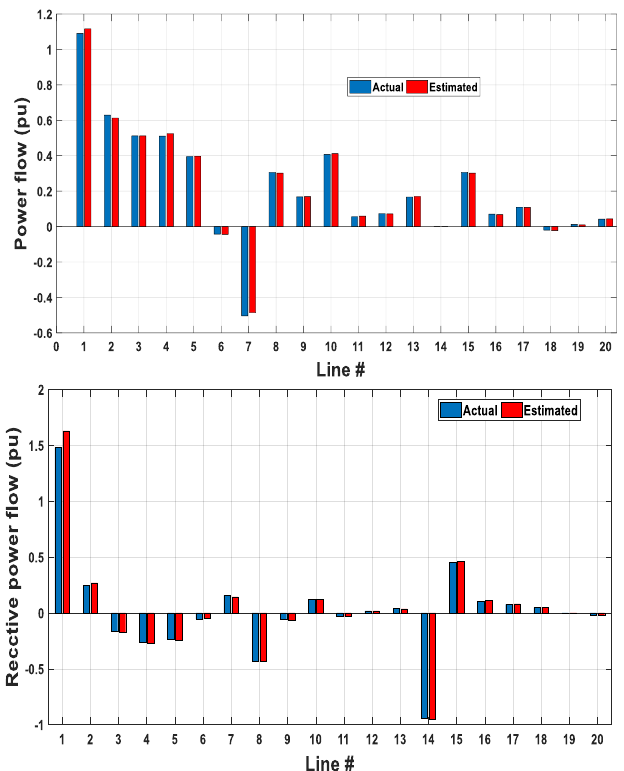
Figure 8. Bus voltages (magnitude and phase angle) of the IEEE 14-bus system from case study-3.